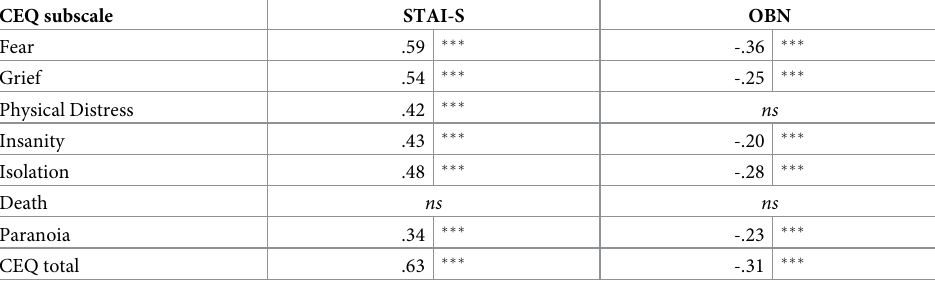
Table 4. Correlations (Pearson’s r) examining relationships between CEQ and the STAI-S and the OBN scale. CEQ